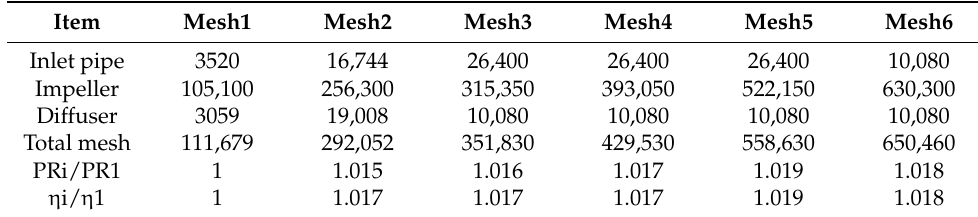
Table 3. Mesh independence